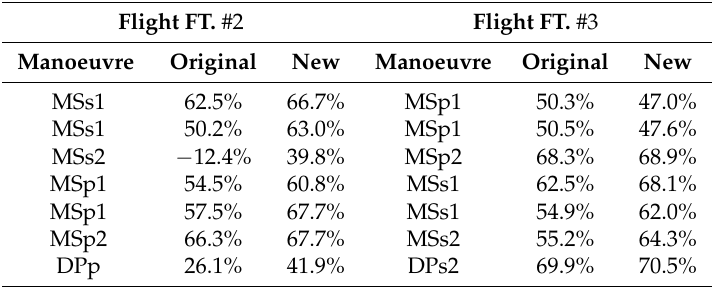
Table 7. Comparison of the original and new method using the aborted test manoeuvre DPs1 as validation data and the model fit criterion as a